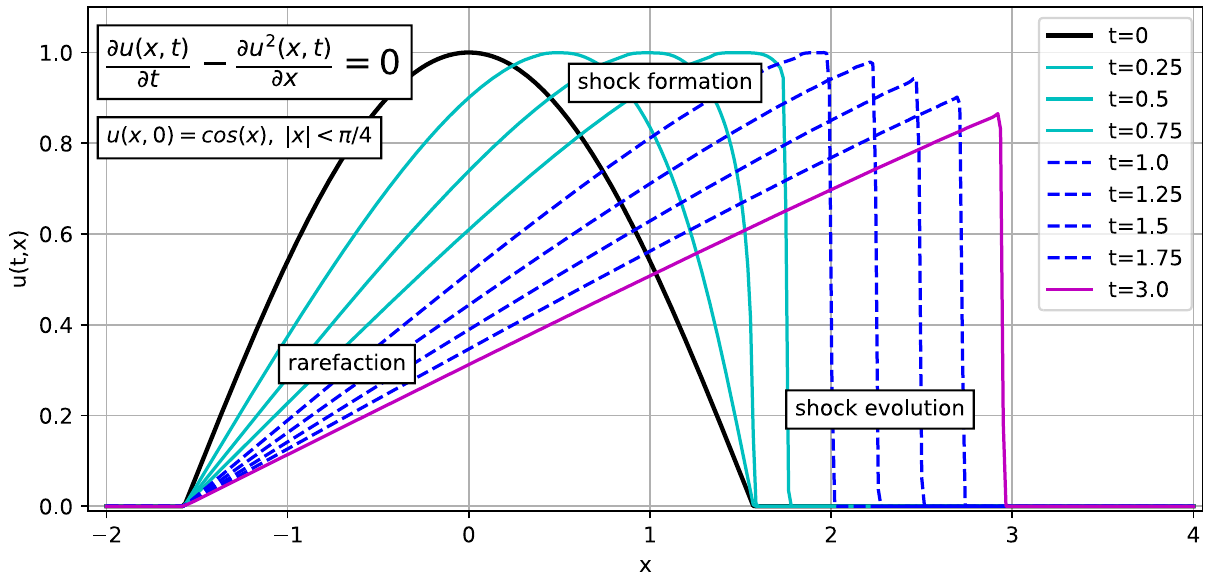
Figure 1. Formation of a shock and rarefaction using the Burgers’ equation. The solution at the initial condition for t = 0 is represented by a cosine function moving from the left to the right and its time evolution using the HRSC FD method. Notice the formation of a discontinuity jump (shock) and the creation of a